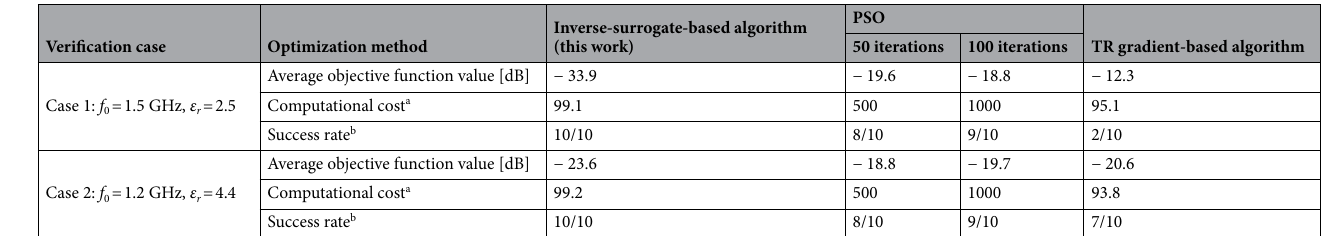
Table 6. Circuit III: optimization results. a The cost expressed in terms of the number of EM simulations of the antenna structure under design. b Number of algorithms runs at which the operating parameters were allocated to satisfy the condition D ( F ( x *), f t ) ≤ D accept